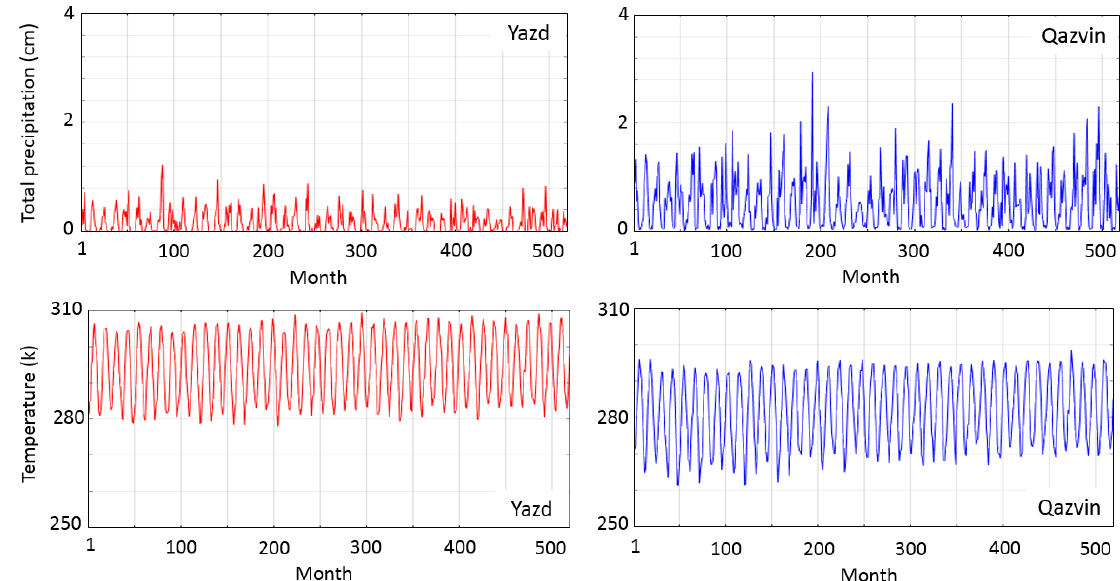
Figure 5. Monthly average of precipitation and temperature at the location of the synoptic station from 1979 to 2021, extracted from ERA5 data. Table 1. Monthly average of precipitation and temperature from 1979 to 2021.